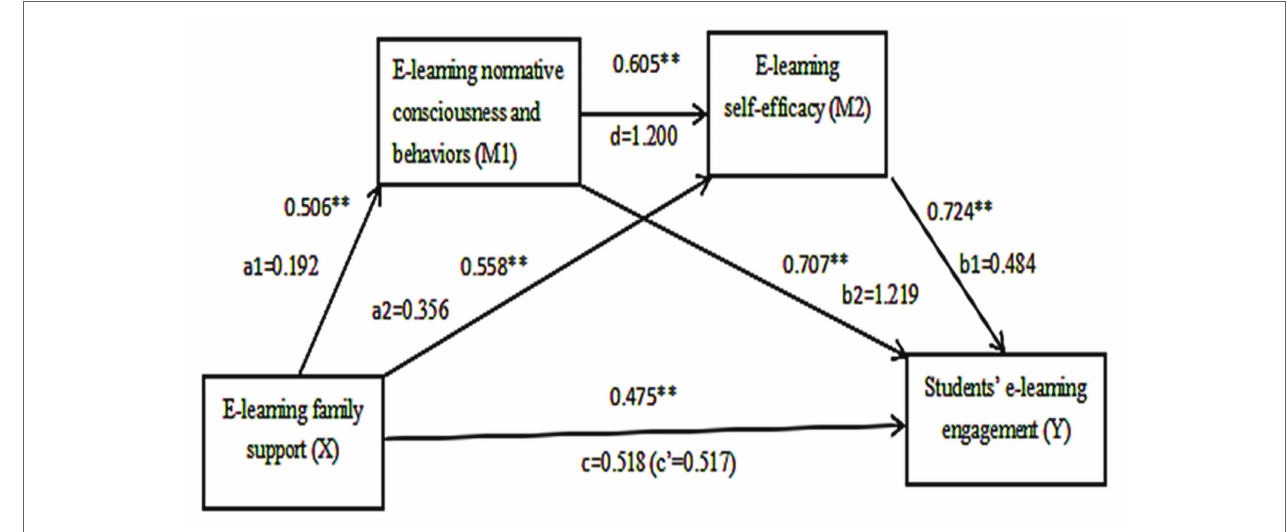
FIGURE 1 | Mediation model of how family support influences students’ e-learning engagement via e-learning normative consciousness and behaviors and e-learning self-efficacy. All study variables are significantly correlated with each other. ** p < 0.001. a1, direct effect of X on mediator M1; a2, direct effect of X on mediator M2; b1, direct effect of mediator M2 on Y; b2, direct effect of mediator M1 on Y; d, direct effect of mediator M1 on mediator M2; c, total effect of X on Y; and c’, direct effect of X on